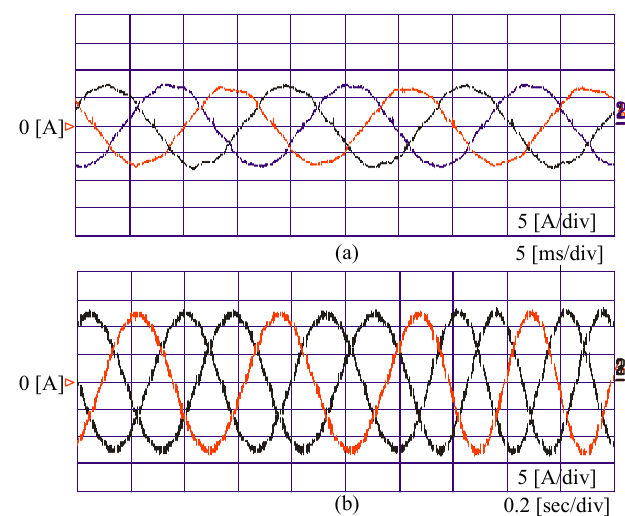
Figure 21. Spectrum of the turbulent wind speed.